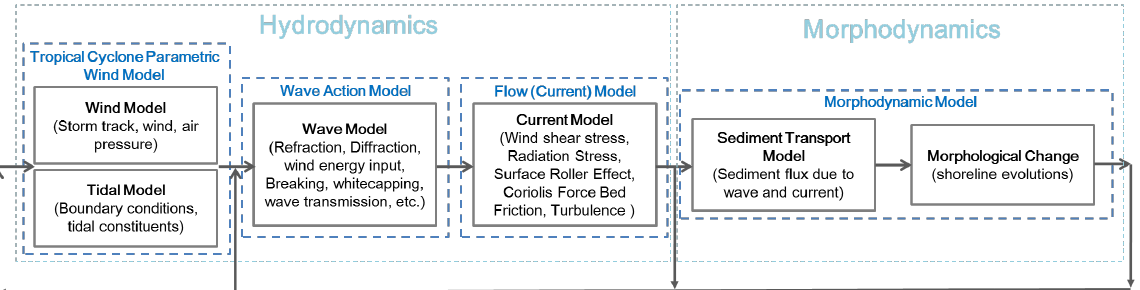
Figure 2. Flow chart of CCHE2D-Coast calculation.